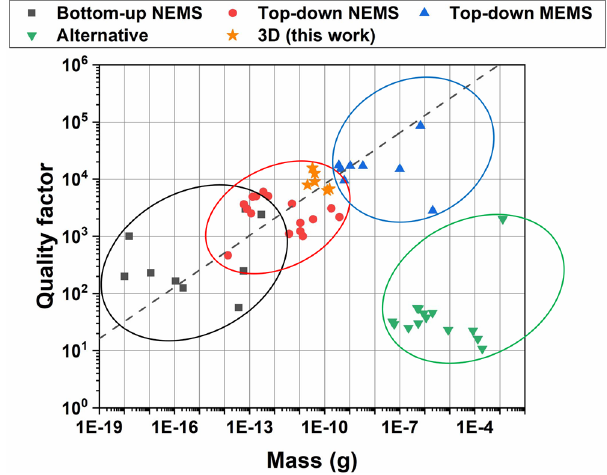
Fig. 1 Quality factors of mechanical resonators from literature as a function of the fabrication method and device mass. The quality factors of mechanical resonators at room temperature are extracted from the literature (references are reported in Supplementary Figs. S1, S2, and S3, and Supplementary Note 1) and divided regarding the fabrication method. Two of our devices with the best performances in terms of high Q factor value and low device mass for each printed resonator structure (cantilever, bridge, and membrane) are reported as star points. The trend of Q ∝ m 1/3 is reported as a dashed